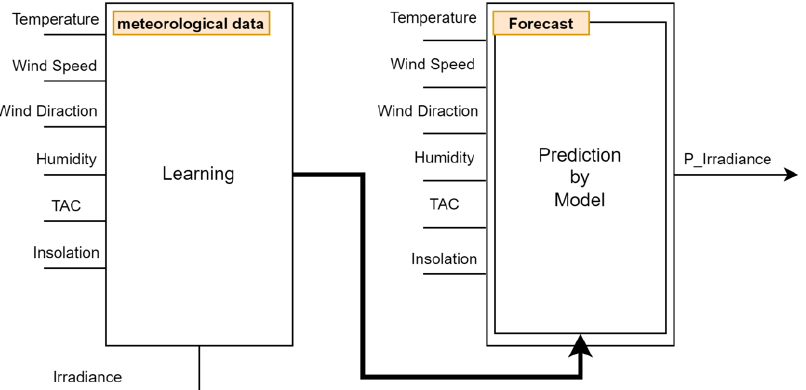
Figure 6. The Processing to make a prediction model about irradiance which get directly above at an SPV Power plant.